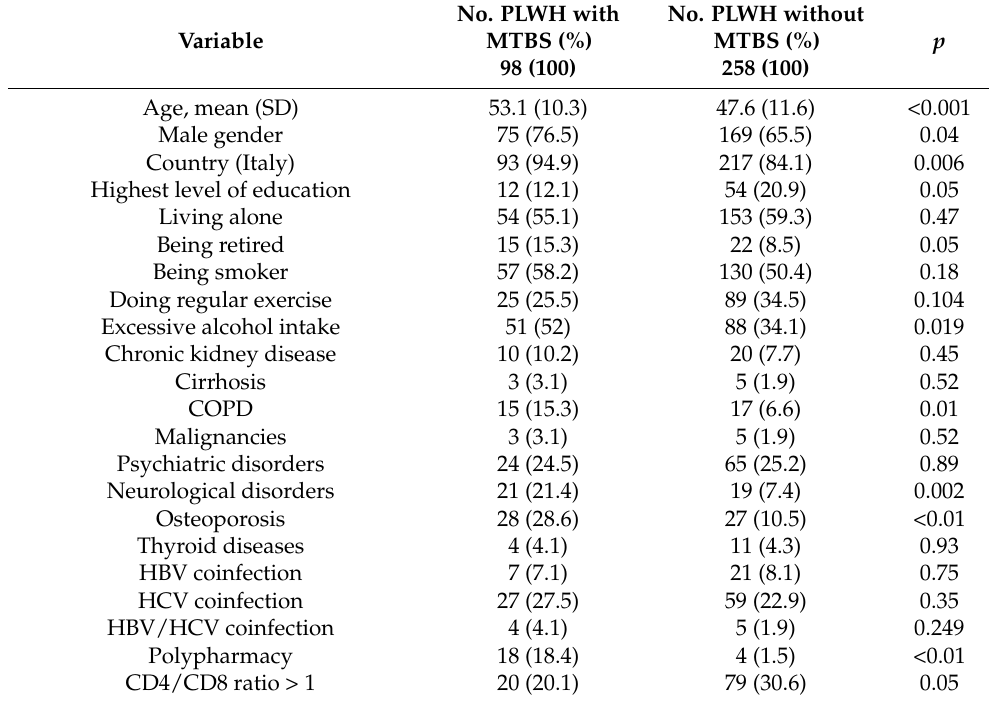
Table 1. Baseline characteristics by presence of metabolic